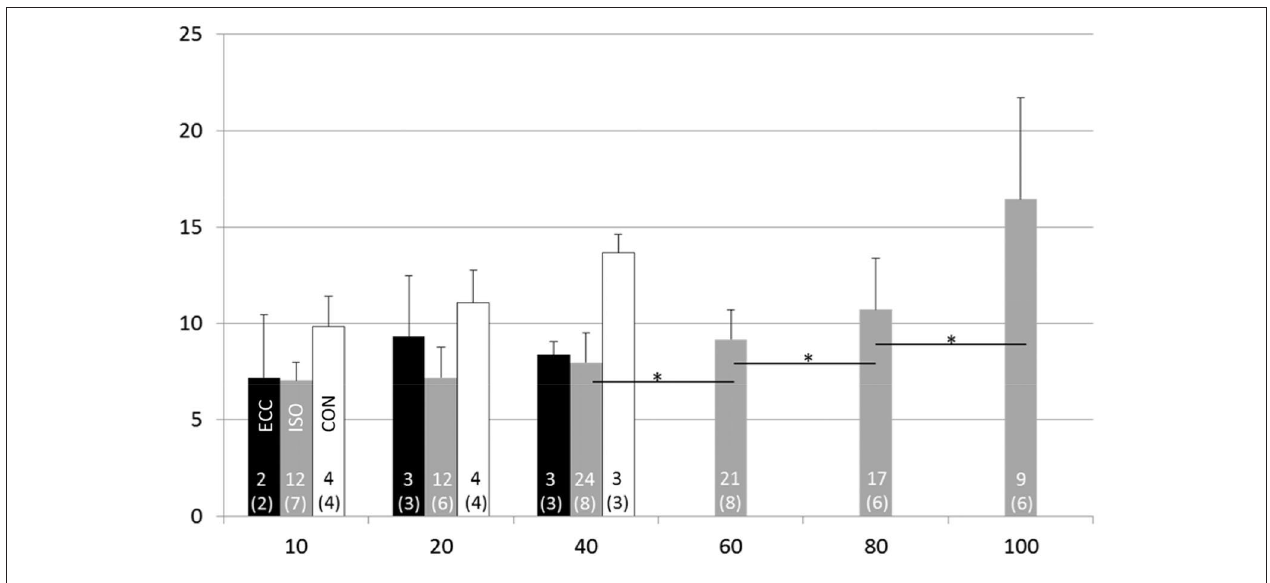
parenthesis) for each contraction type and activation level are displayed at the bottom of each bar. * = difference between action levels ( p <